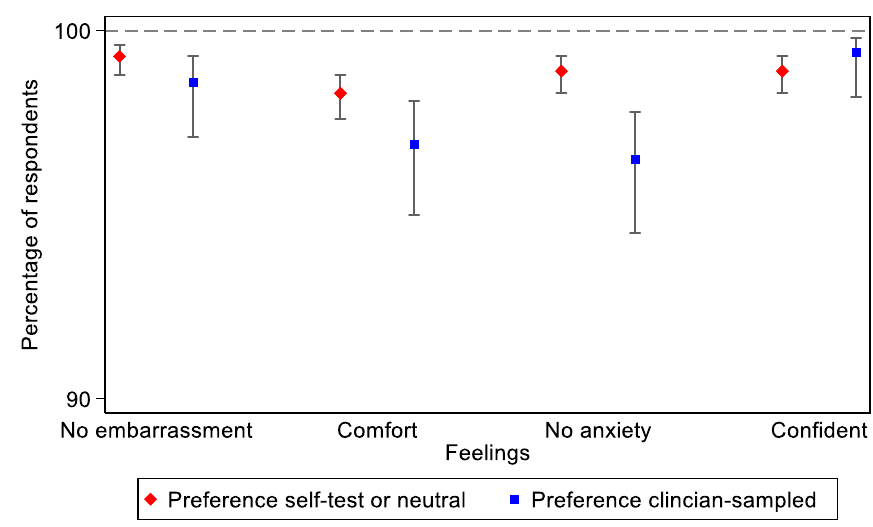
Figure 1. Comparison of women’s experiences with Self-HPV (preference for self-test or neutral vs. clinician-sampled).